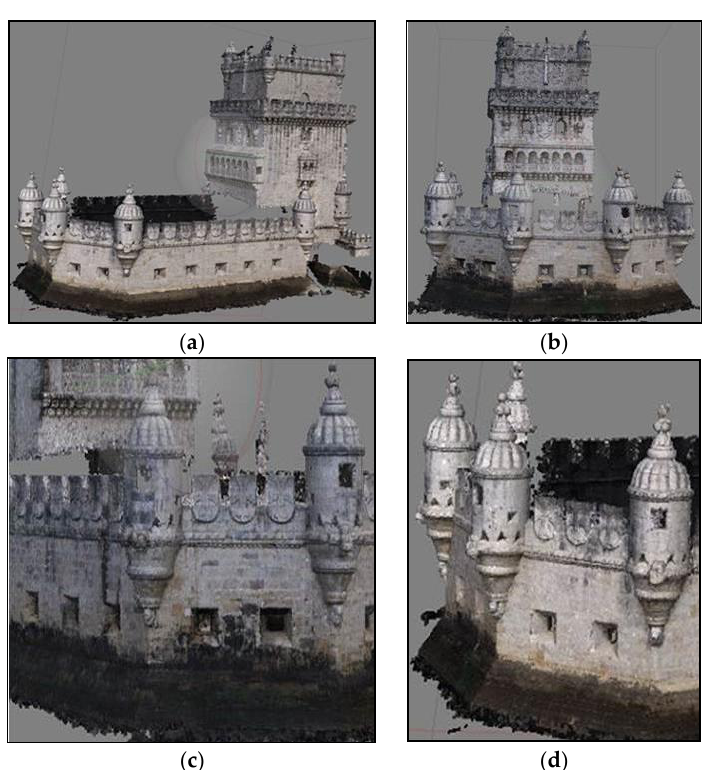
Figure 5. Photogrammetric 3D point cloud: ( a ) East wall; ( b ) South wall; ( c ) and ( d ) Details of the South wall.